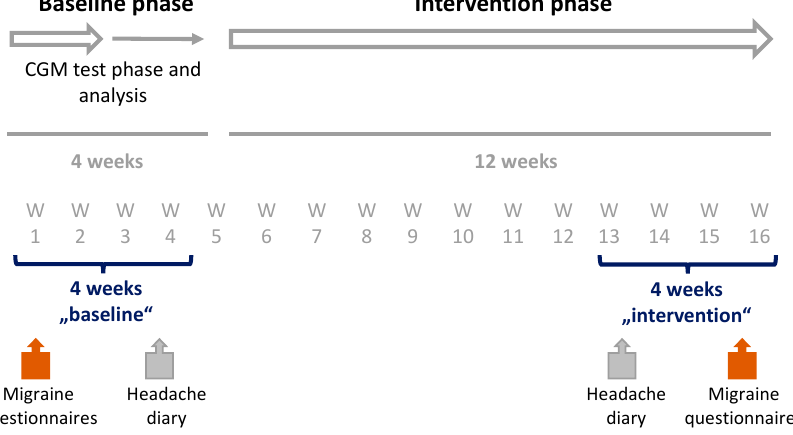
Figure 1. Study design. Patients used the DTx sinCephalea over the course of 16 weeks. The baseline phase was set to be the first four weeks in which patient’s glucose reaction were recorded with a continuous glucose monitoring device (CGM) and the personalized dietary recommendations were determined. Disease severity was assessed with a headache diary and validated migraines questionnaires on impairment in daily life (Headache Impact Test 6-items [HIT-6] and Migraine Disability Score [MIDAS]), and quality of life (EQ-5D-5L). This was followed by a twelve-week intervention phase, in which dietary recommendations were implemented. In the last four-weeks of intervention phase, the disease severity was assessed again for an intra-individual pre-post comparison.